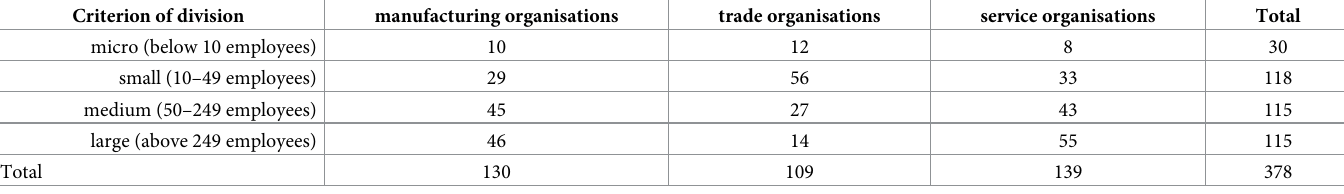
Table 1. Research sample